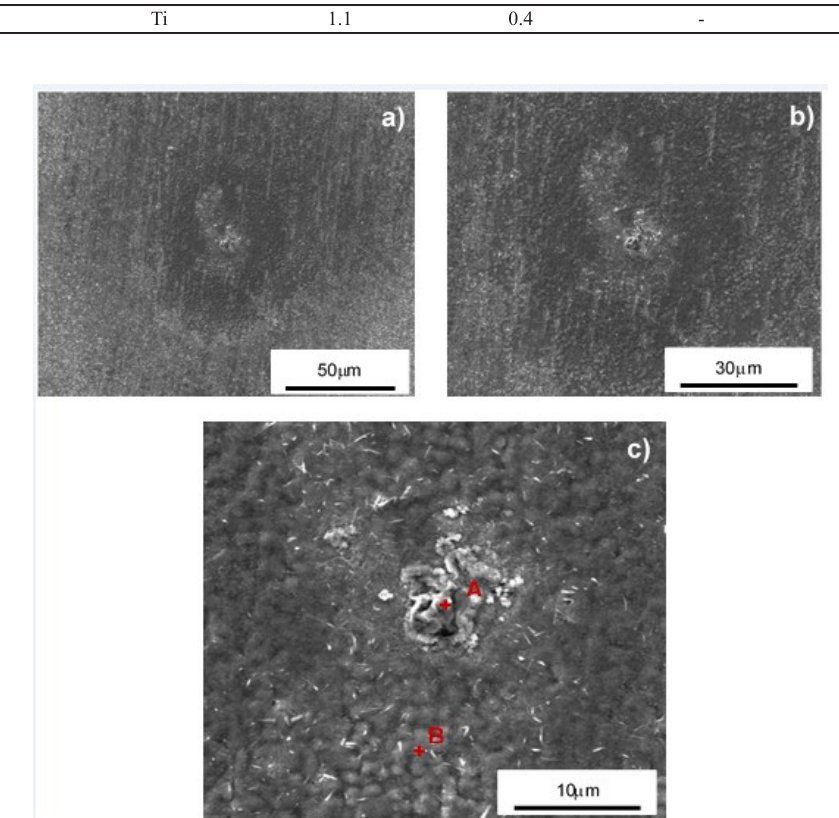
/steam/N atmosphere on maraging 350 2 2